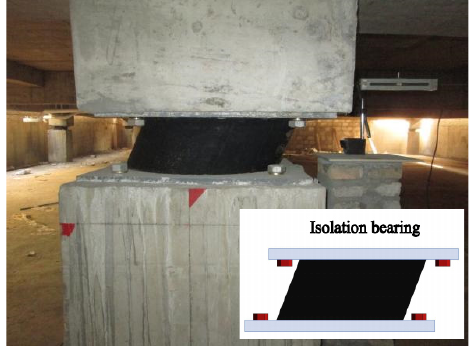
Figure 13. Schematic diagram of initial displacement application.